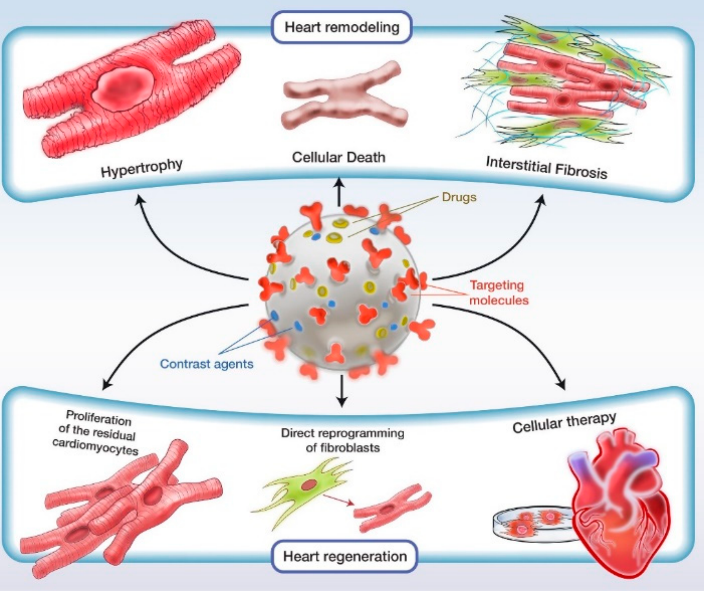
Figure 1. Application of nanoparticles in cardiovascular therapy and imaging.